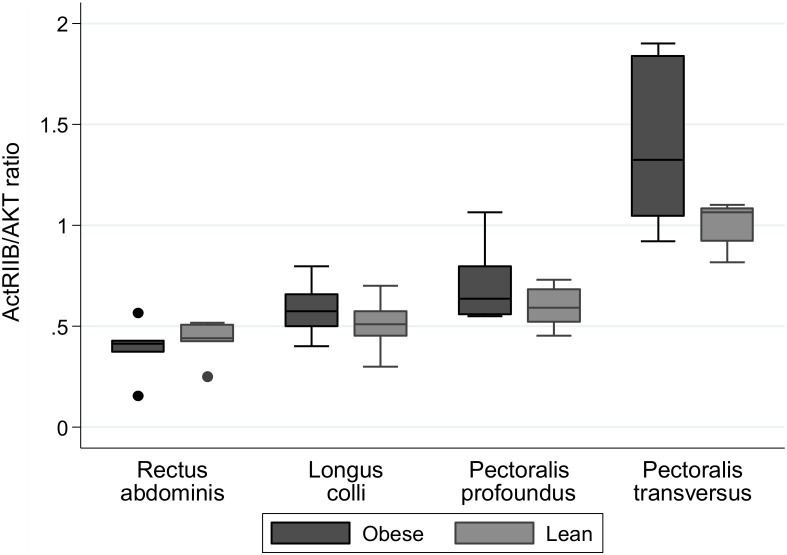
Protein expression of ActRIIB protein in skeletal muscles of lean and obese horses and ponies.Protein expression of ActRIIB protein (∼50 kDa) was assessed by Western blot with total AKT used as a loading control. Mean densitometric signals were calculated from three independantly repeated Western blots. n = 6/group.